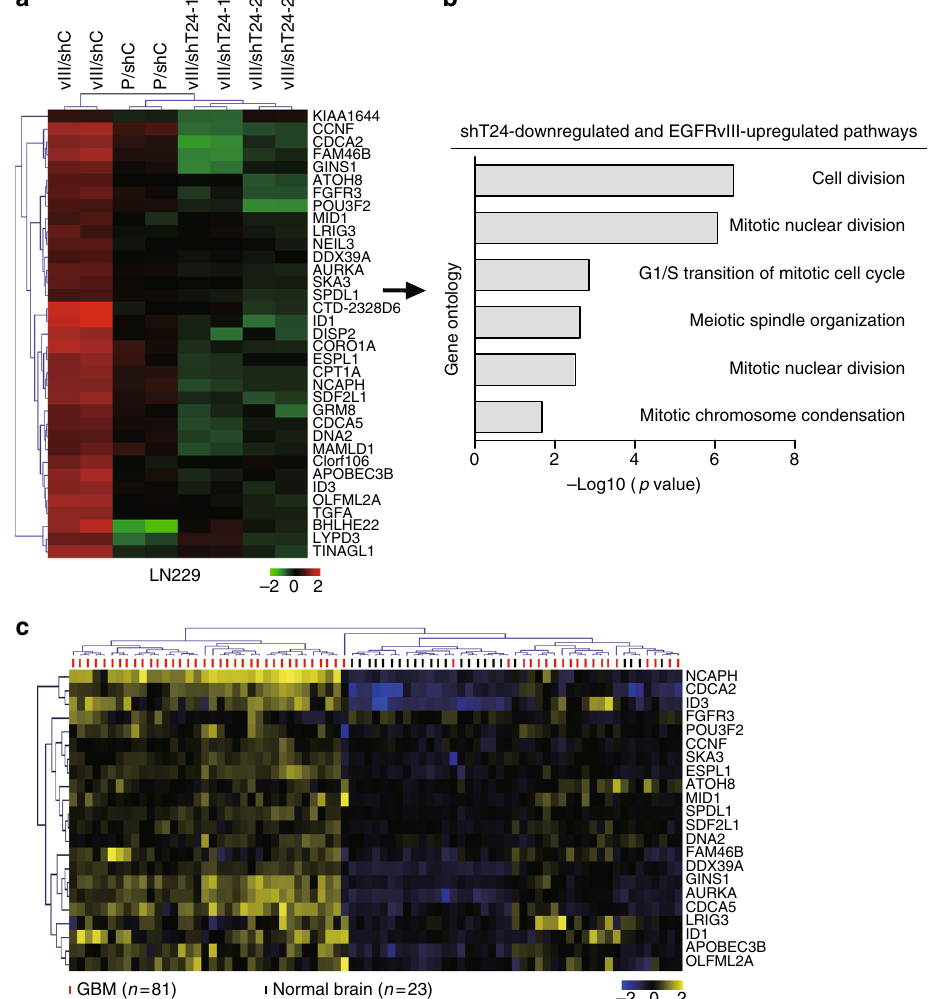
Fig. 5 TRIM24 and EGFR co-upregulated genes are highly expressed in clinical GBM specimens. a Heatmap of mRNA-Seq analysis of differentially expressed genes (2-fold change and FDR < 0.05) among LN229/P/shC, LN229/vIII/shC, LN229vIII/shT24-1 and LN229vIII/shT24-2 GBM cells. TRIM24 and EGFR-regulated genes were de fi ned to be upregulated by EGFRvIII overexpression and downregulated by knockdown of TRIM24. b Gene ontology (GO) analysis indicates that genes upregulated by EGFRvIII and downregulated by TRIM24 knockdown are associated with cell proliferation pathways. c Hierarchical clustering analysis of patient gene expression data (GSE4290) indicates that the 22-gene signature resulted in two main clusters indicated in blue and yellow, respectively. Expression data of 23 non-tumors (brain tissues from epilepsy patient) and 81 GBM were downloaded from GSE4290